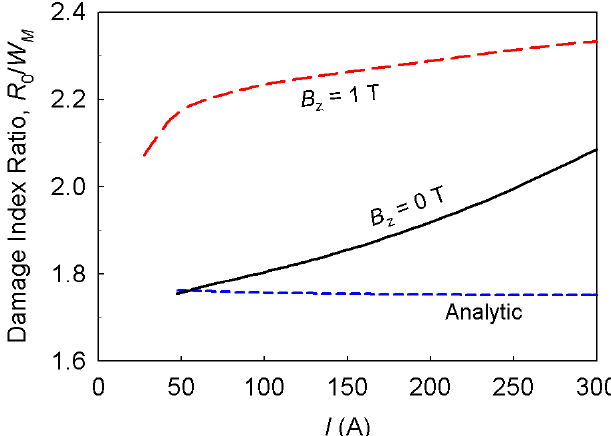
FIG. 6. (Color) Quasistatic model predictions for damage (cid:7) 250 (cid:2) m and n index ratio versus current with R 0 is the external solenoid 4 (cid:6) 10 16 cm (cid:3) 3 . B z